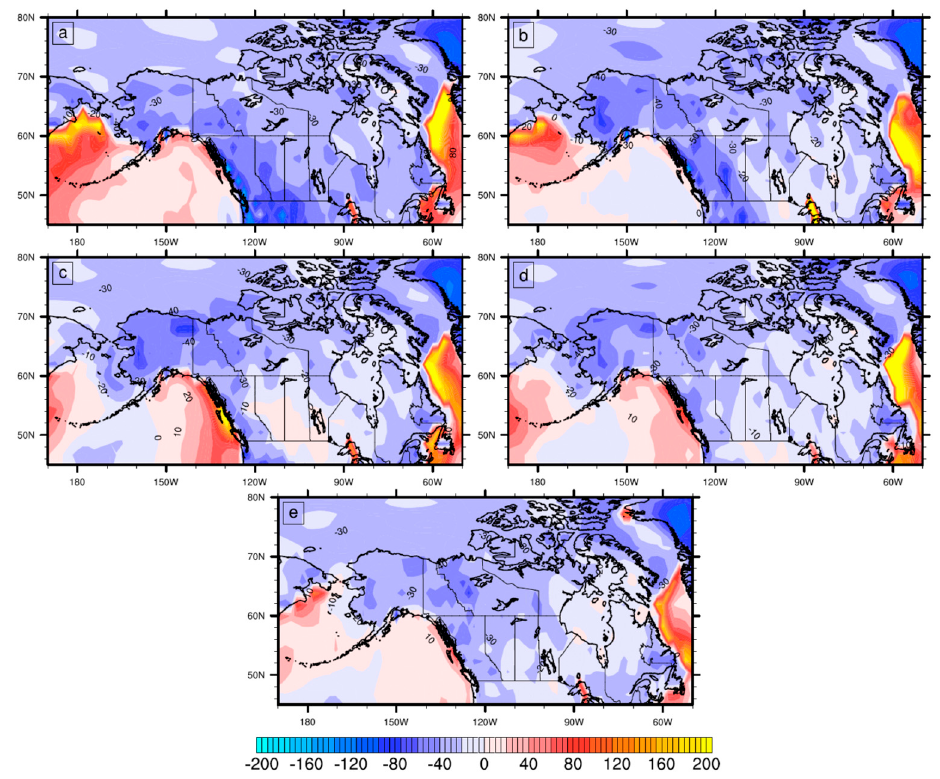
Figure 9. Sensible heat flux (W m − 2 ) in ( a ) 1–15 January; ( b ) 16–31 January; ( c ) 1–14 February; ( d ) 15–28 February; ( e ) 1–11 March, 2019.